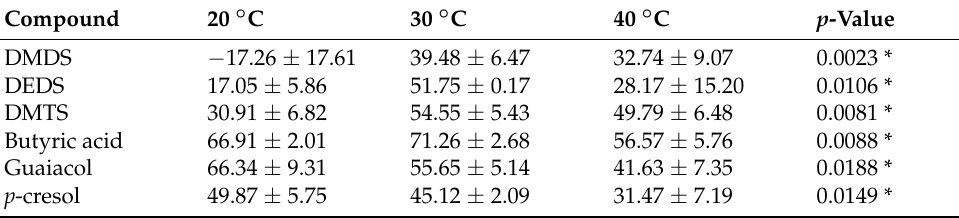
Table 6. VOC reduction rate (%) at different reaction temperatures.